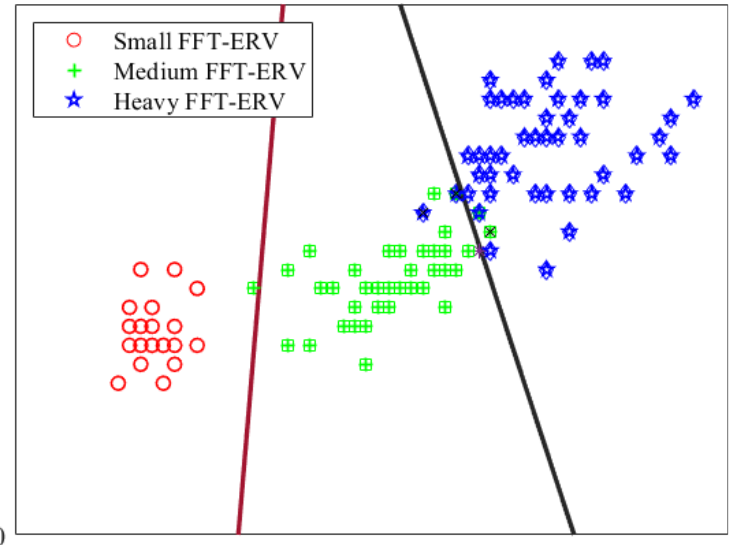
Figure 12. SVM classification of a foam fire truck emergency rescue vehicle.